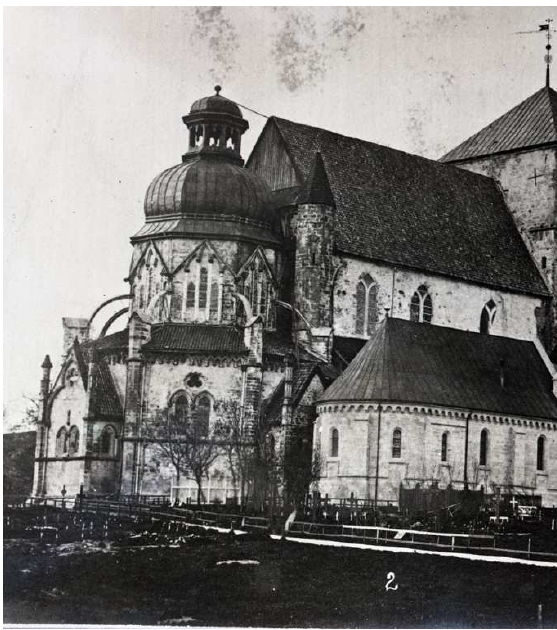
Figure 1. The Octagon before 1872; NDR Archive: Nr. 002 Figure 2. The Octagon after 1888; NDR Archive: Nr.